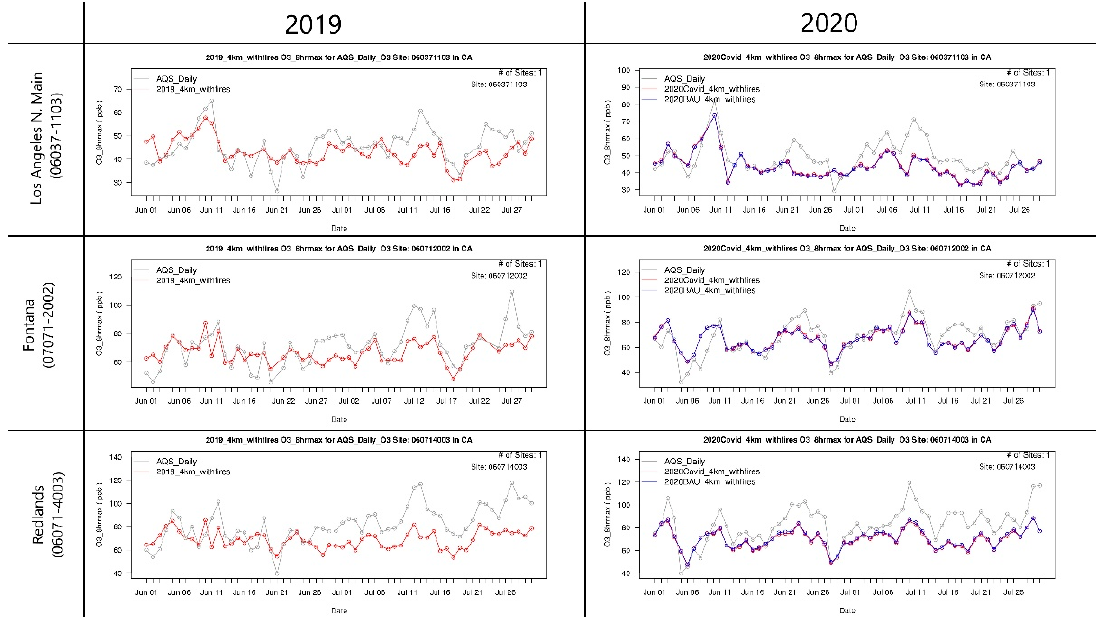
Figure 6. Example timeseries plots for 2019 and 2020 for Los Angeles N Main, Fontana, and Redlands monitors.